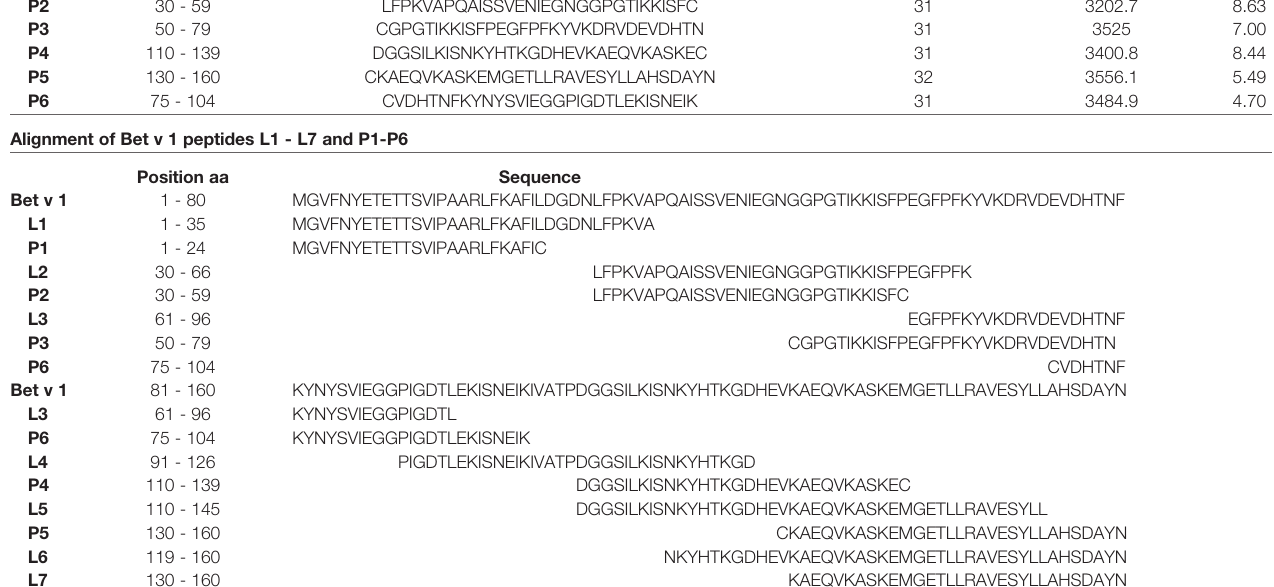
Bet v 1-derived short